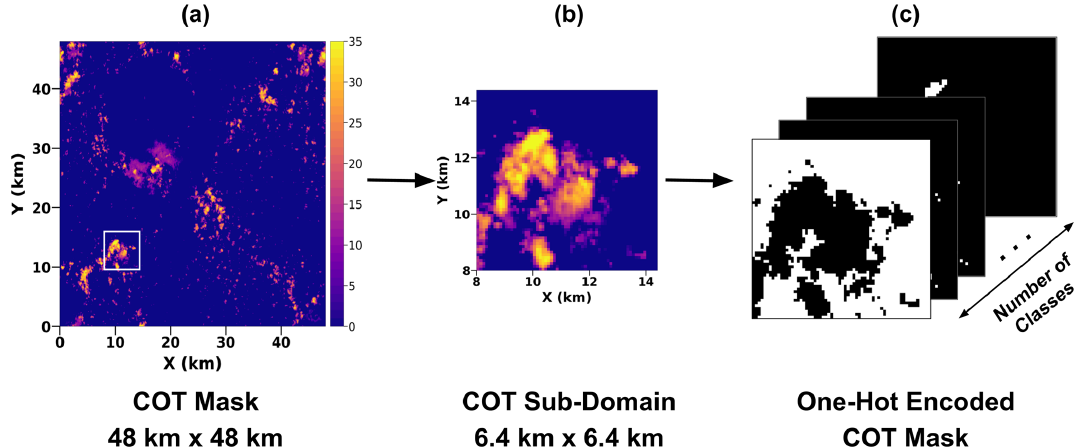
Figure 5. One-hot encoding translates a 2D discrete COT mask to a 3D image with N binary masks. (a) A 48km × 48km discrete COT mask. The white box highlighted is a 6.4km × 6.4km sub-domain, which is shown in (b) . Panel (c) shows the one-hot-encoded COT that has the dimensions 64 × 64 × N ; a pixel viewed depth-wise (along the channel axis) would have N classes of COT. Each layer represents a bin interval of the range of COT. For instance, the white pixels in the top layer have COT < 0.1. Similarly, in the second layer, the white pixels are those whose COT lies in the interval [ 0 . 1 , 0 . 2 ) . The final layer’s white pixels have COT > 100. In our case, N =